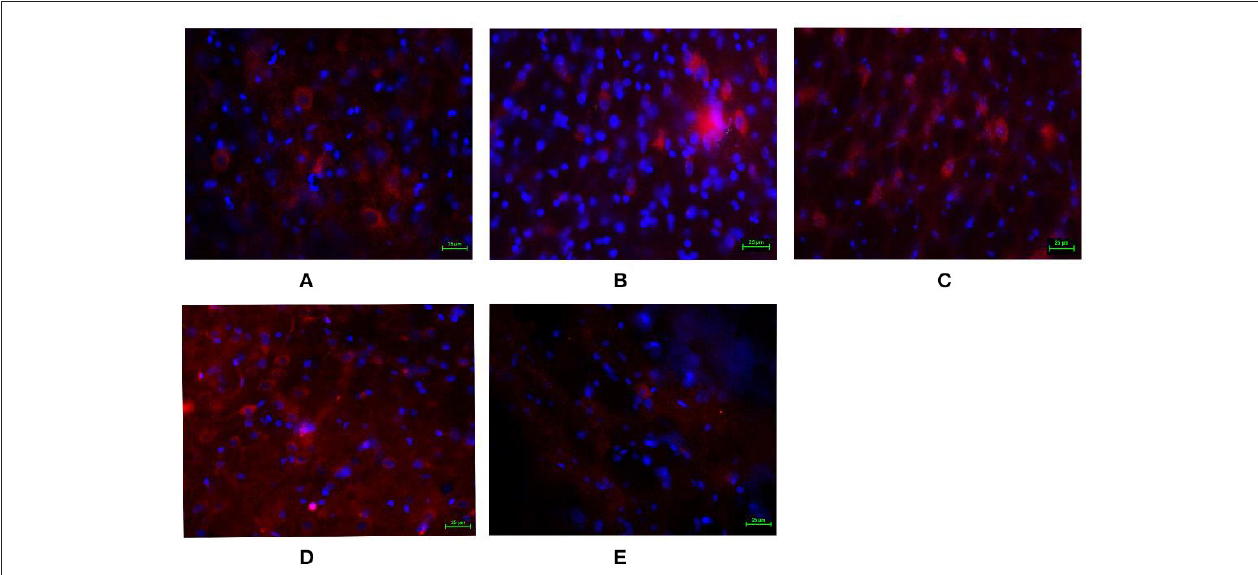
FIGURE 3 | Immunofluorescence expression of GABA B receptor in the LHA. Immunofluorescence analysis of expression of GABA B receptor in the LHA. (A) Normal group; (B) GI-R group; (C) FN + GI-R + L -Glu group; (D) LHA + GI-R + Baclofen group; (E) LHA + GI-R + CGP35348 group. n = 5.